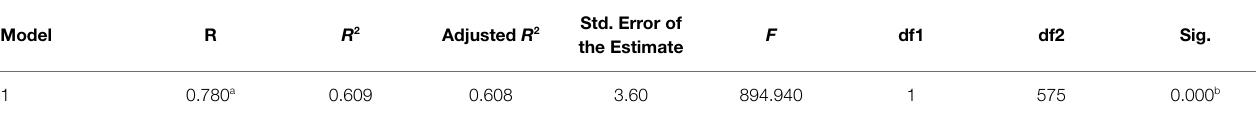
TABLE 5 | Model summary and ANOVA test of linear regression analysis for mindfulness as a predictor of motivation.